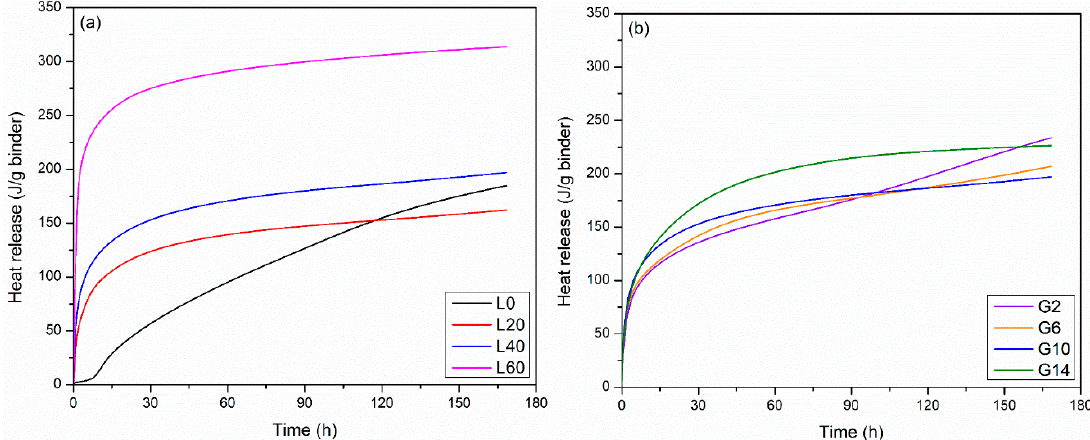
Figure 2. Early age heat release of ( a ) group L mixtures and ( b ) group G mixtures.